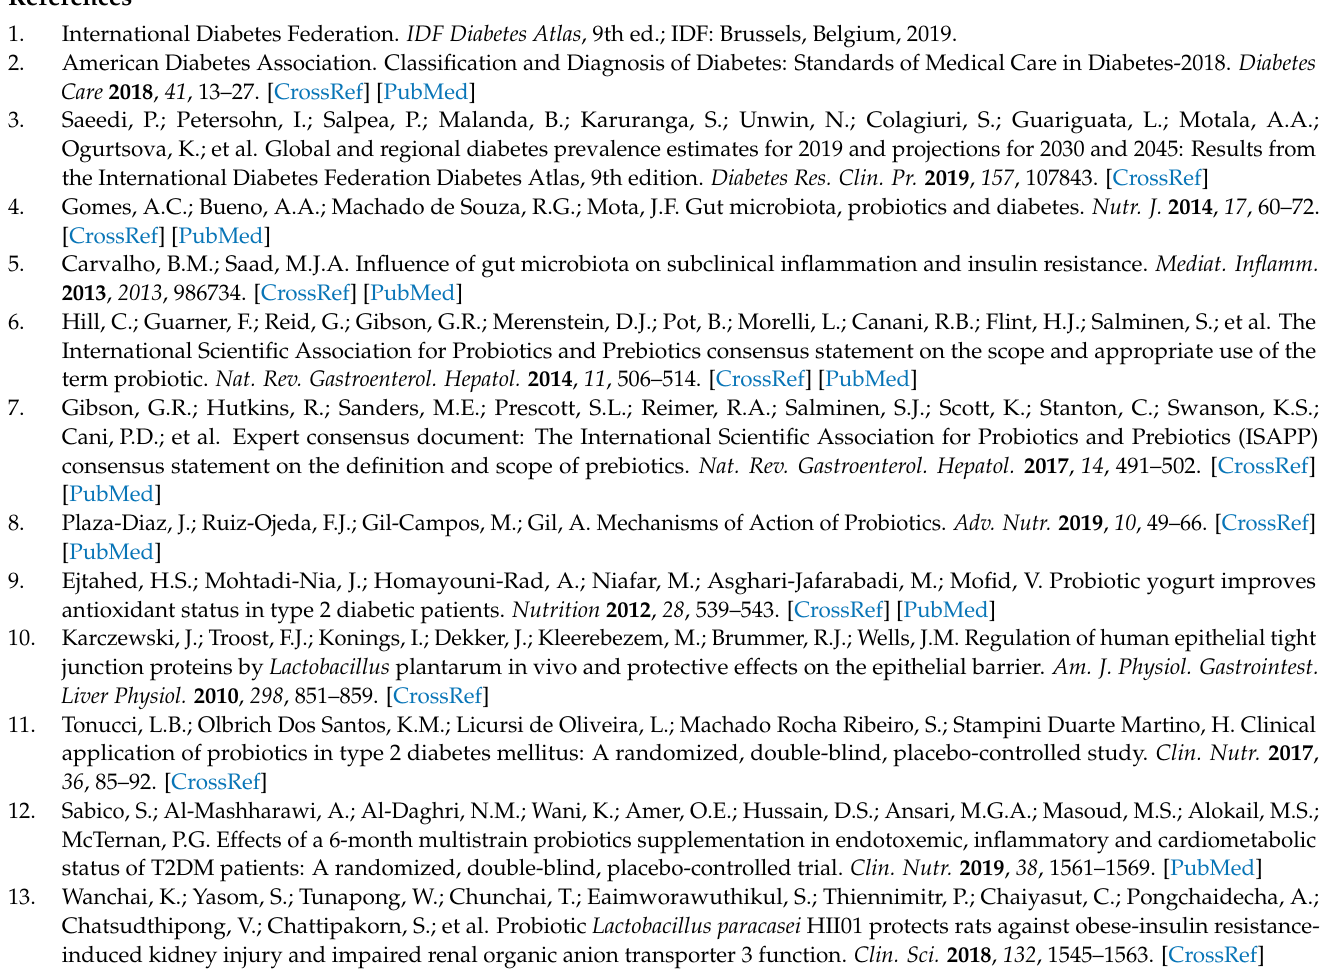
Table S2: Oral antidiabetic drugs used by